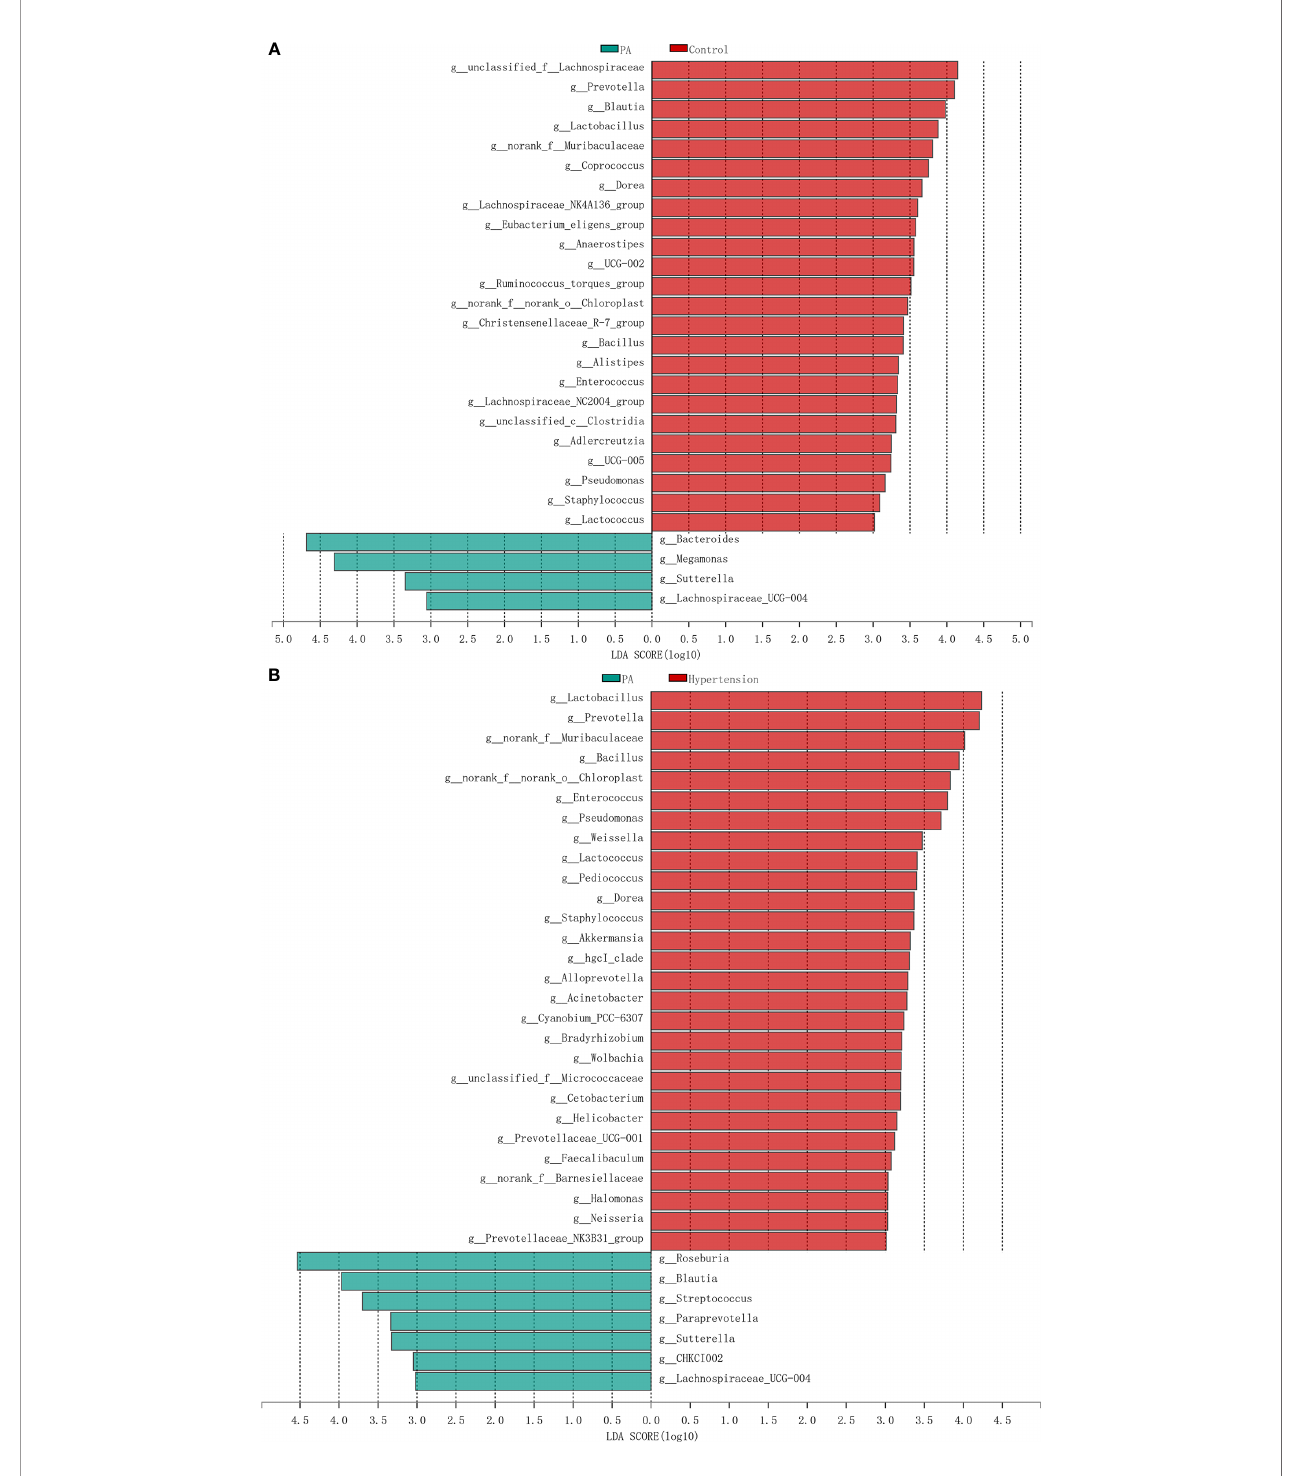
FIGURE 3 | Differences in intestinal bacteria between primary aldosteronism (PA) patients, primary hypertension patients, and healthy controls. (A) Signi fi cantly different genera between PA patients and healthy controls. Red bars are genera with higher relative abundances in healthy controls. Green bars are genera with higher relative abundances in PA patients. (B) Signi fi cantly different genera between PA patients and primary hypertension patients. Red bars are genera with higher relative abundances in primary hypertension patients. Green bars are genera with higher relative abundances in PA